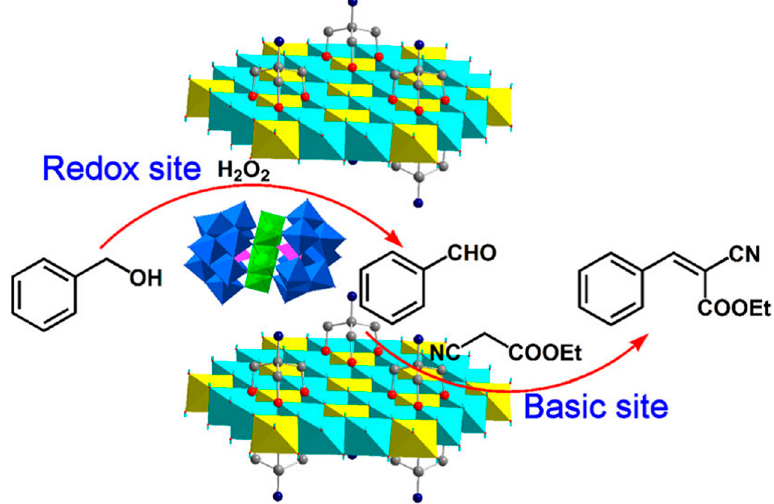
Figure 10. Schematic of the reaction pathway of the one ‐ pot tandem reaction catalyzed by Tris ‐ LDH ‐ Zn 4 (PW 9 ) 2 . Reproduced from Ref. [65], Copyright 2016, WILEY ‐ VCH. (PW 9 ) 2 . Reproduced from Ref. [65], Copyright 2016,